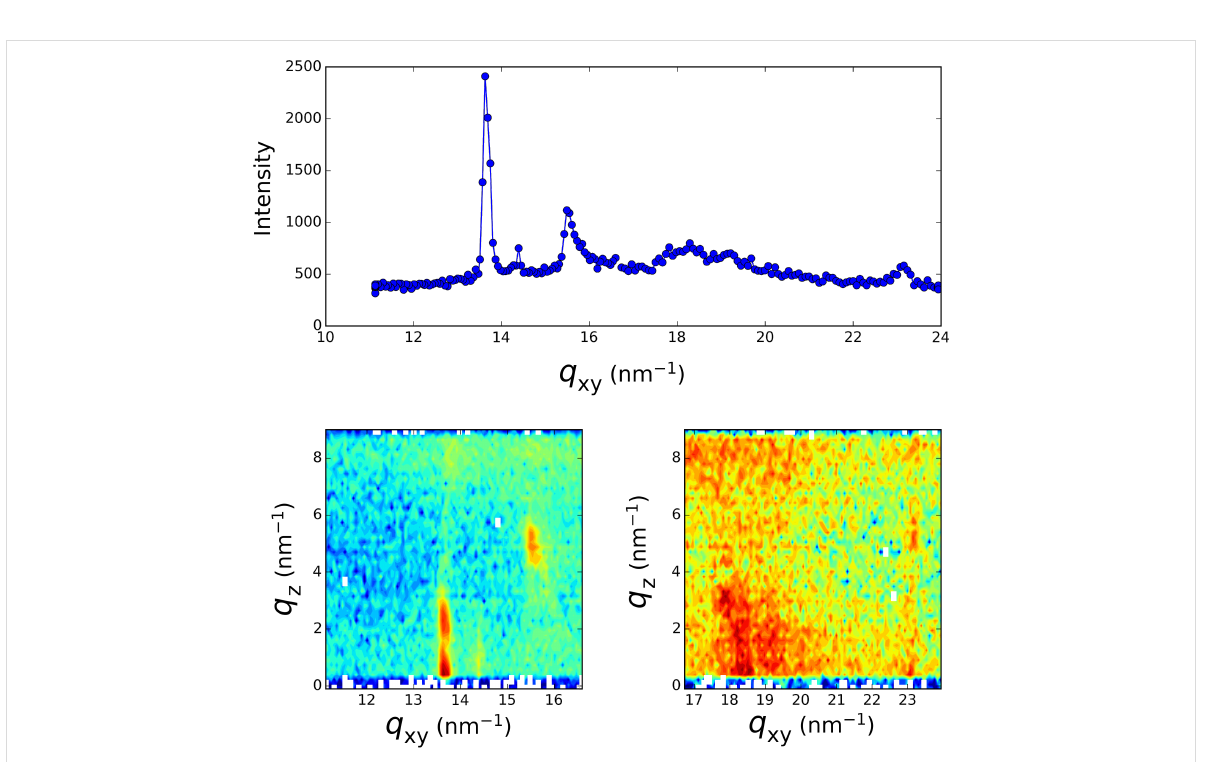
Figure 3: Grazing incidence X-ray diffraction spectrum taken after two hours into the irradiation process of Figure 1c. Top: q z integrated spectrum, Bottom: q xy − q z intensity